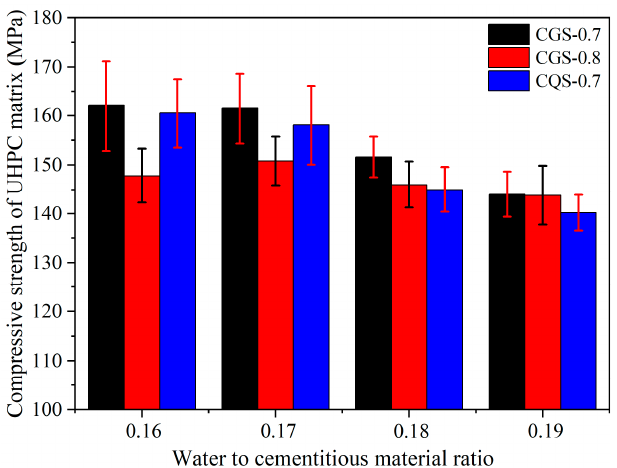
Figure 4. The compressive strength of the UHPC matrix.